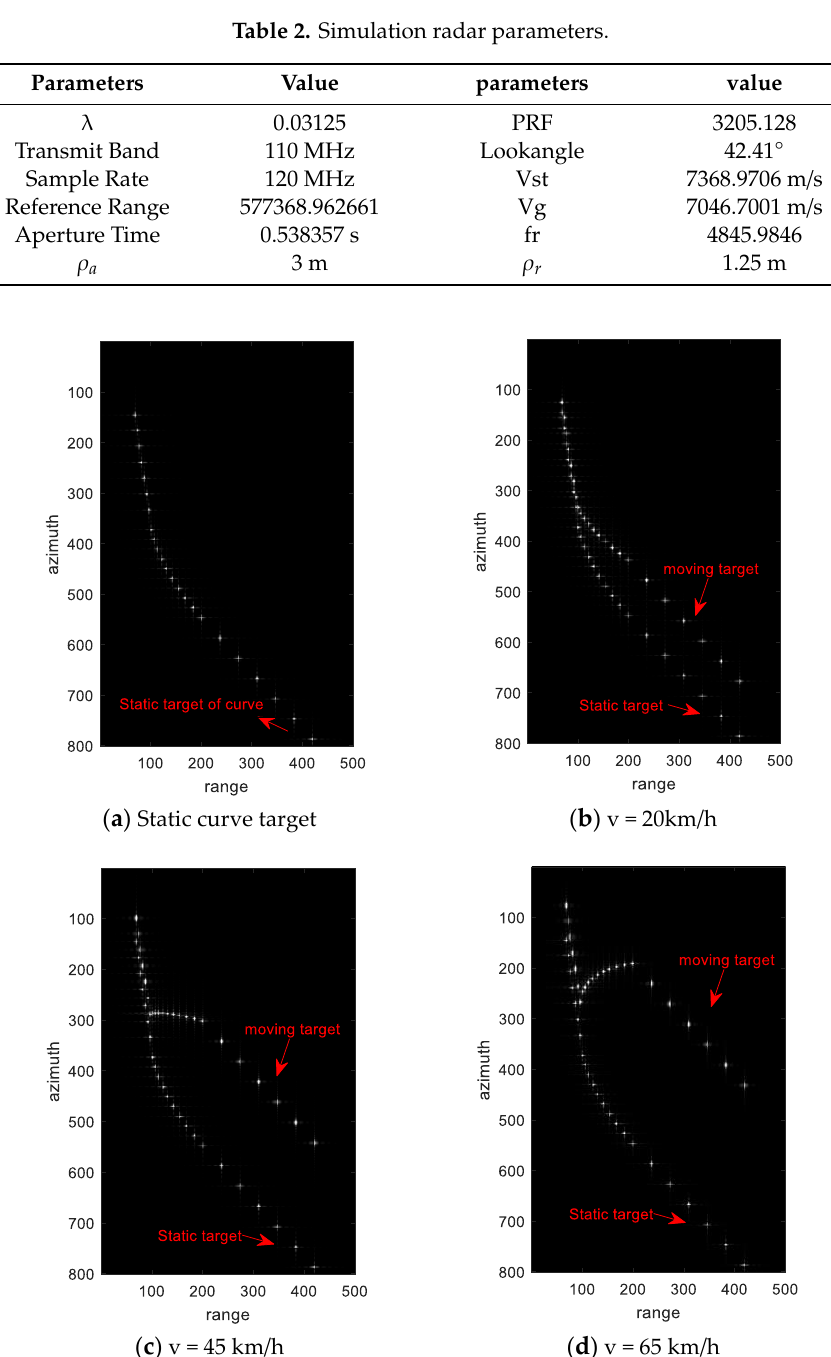
Figure 4. Simulation results of turning motion targets with velocity 20 km/h 、 45 km/h and 65 km/h.